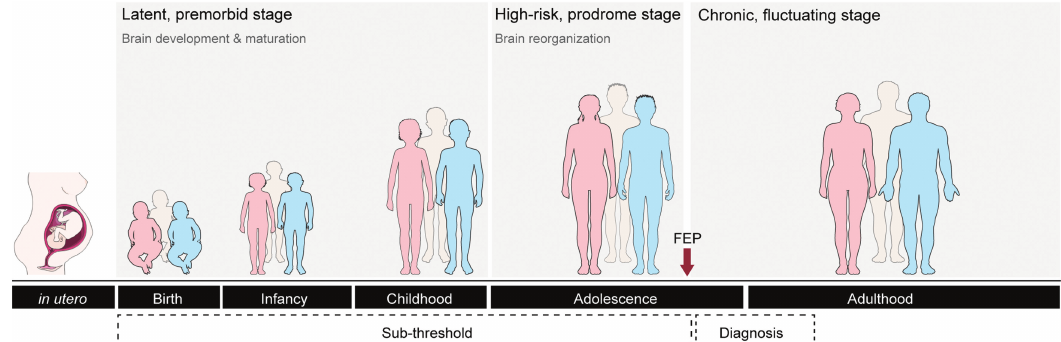
Fig. 1 Schizophrenia progression involves three stages. (1) latent, pre-morbid (from the prenatal period until childhood) implicates biological processes intrinsic to brain development and maturation; (2) high-risk, prodromal (usually initiates in adolescence) - impacts on brain reorganization (e.g. sexual maturation); and (3) chronic, fl uctuating (adulthood).